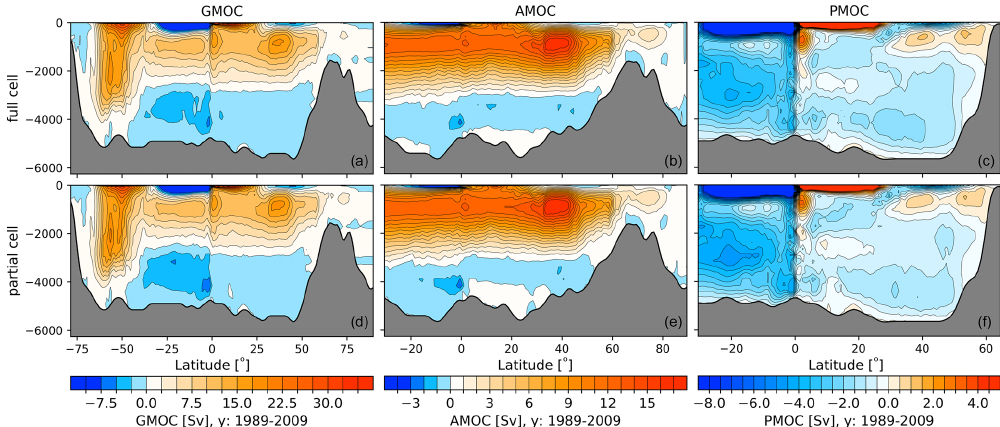
Figure 5. Global (GMOC, a, d ), Atlantic (AMOC, b, e ) and Indo-Pacific (PMOC, c, f ) meridional overturning circulations for full cells (a–c) and partial cells (d–f) averaged for the time period 1989–2009.